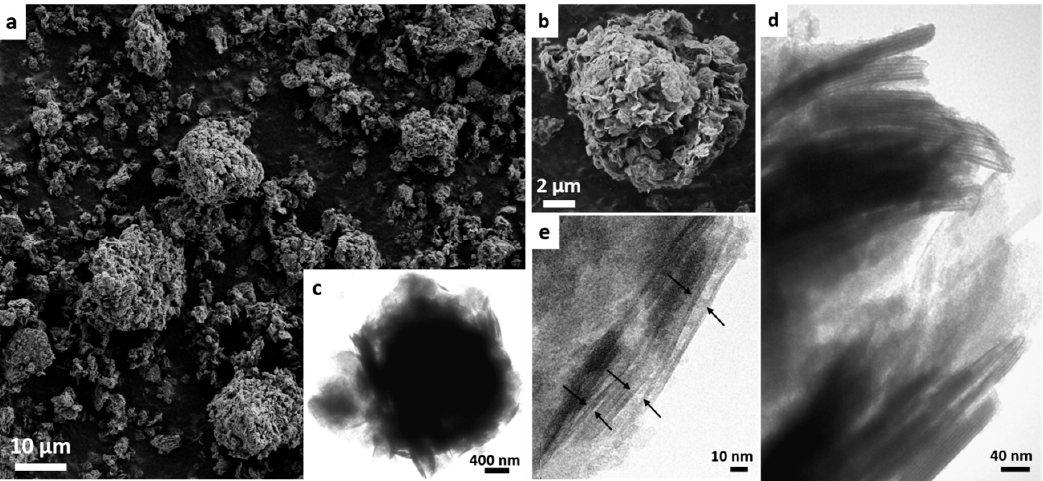
Figure 3. SEM micrographs ( a , b ) and TEM images ( c – e ) of the MWW-HT-ST-Pil product.